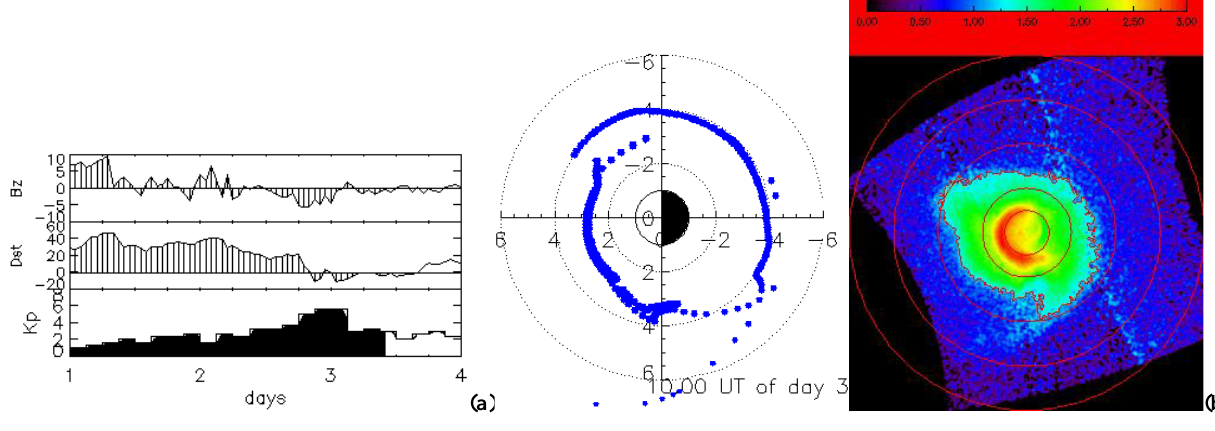
Fig. 6: Same as Fig. 1 for June 10, 2001, 10h00 (left panel (a), simulation) and 9h57 UT